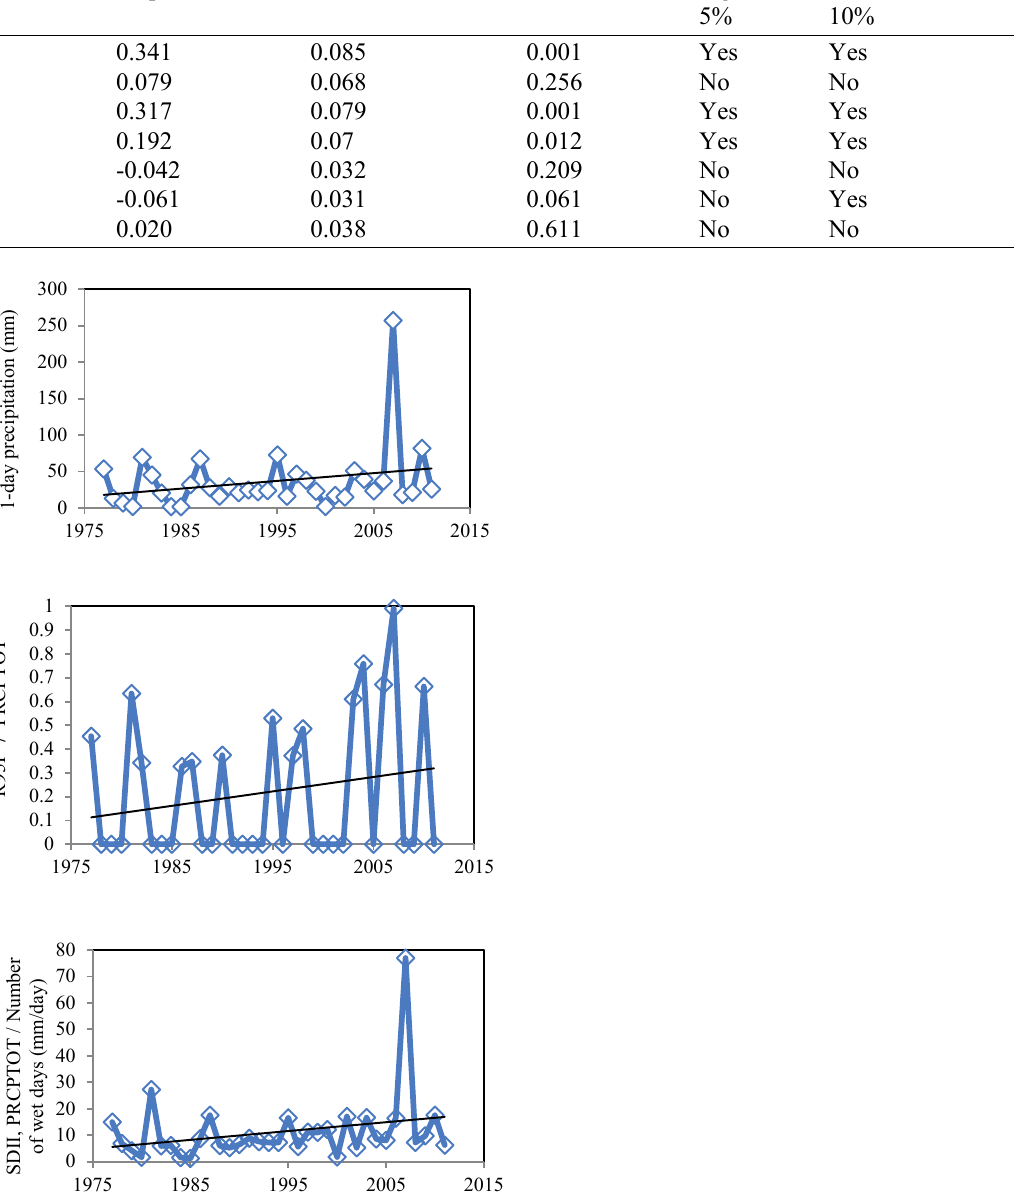
Fig. 4 Trends of different precipitation indices: (a) heavy precipitation, (b) contribution from very wet days, and (c) daily